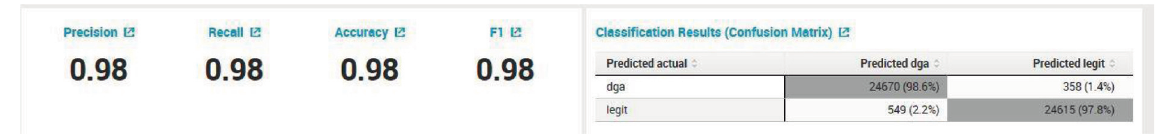
Figure 15: Evaluation of the decision tree model along with the characteristics diagram using the principal component analysis